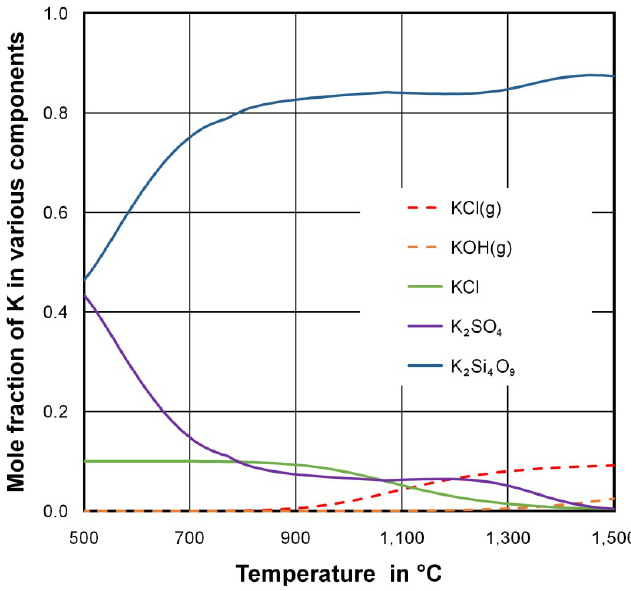
Figure 6. Equilibrium distribution of potassium on various components and phases as a function of the temperature.